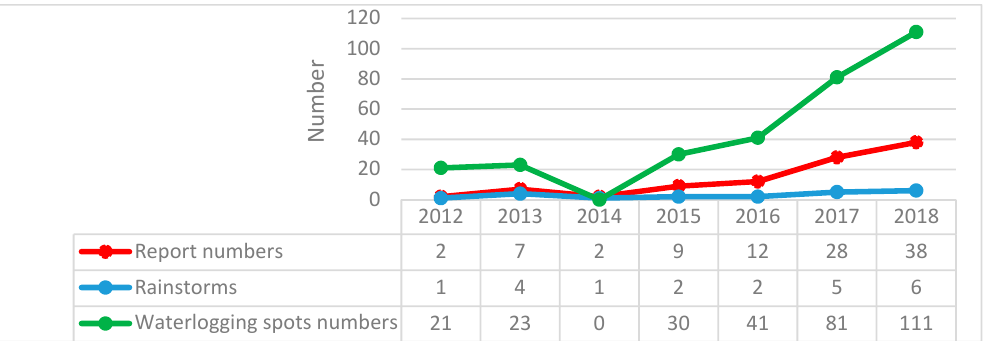
Figure 2. Report numbers of the period 2012–2018.